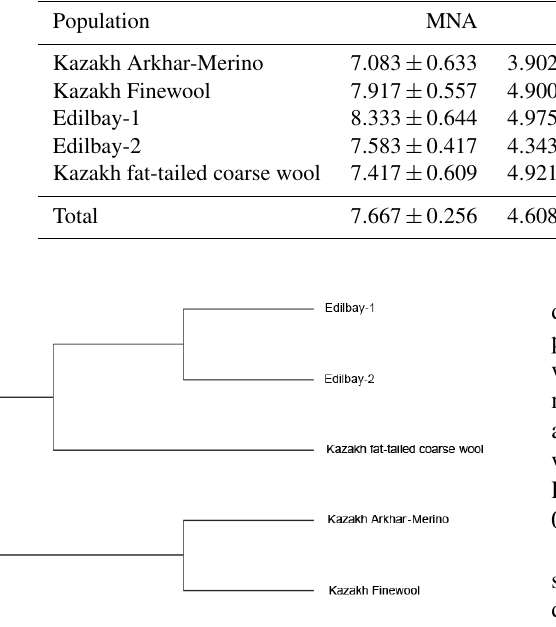
Figure 1. The phylogenetic tree constructed from Nei’s standard genetic distances among five sheep